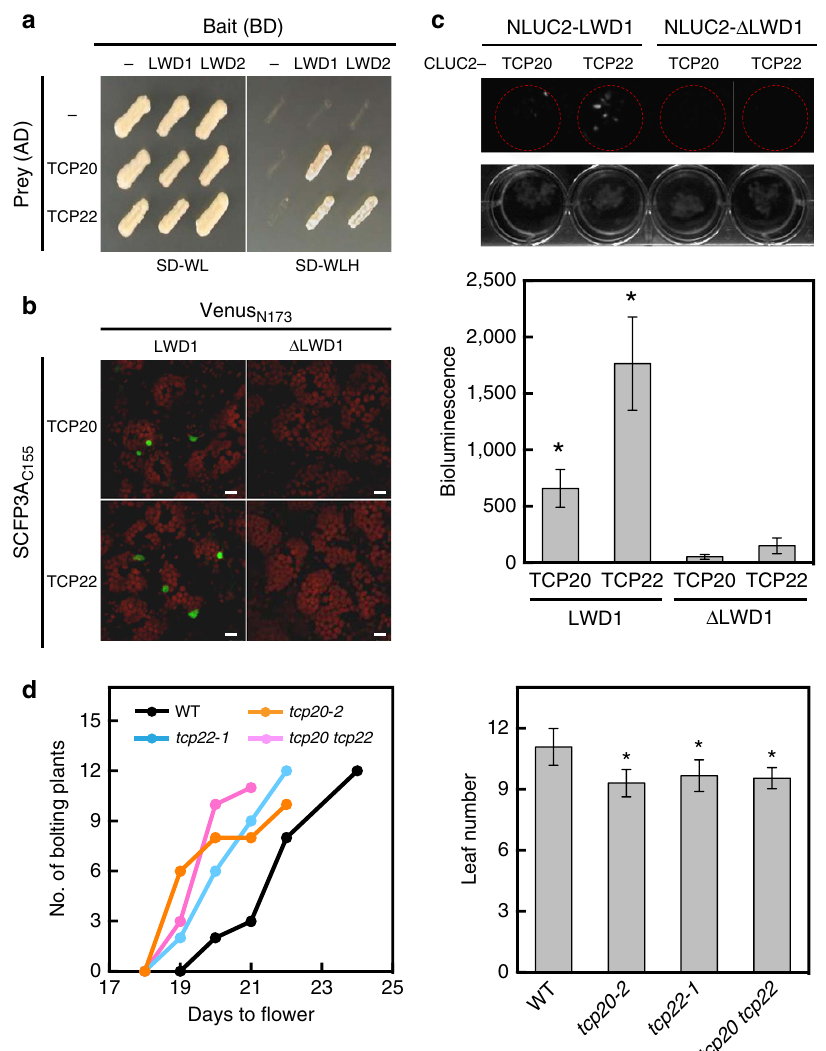
Figure 2 | TCP20/TCP22 interact with clock proteins LWD1/LWD2 and regulate flowering time. ( a ) LWD1/LWD2 and TCP20/TCP22 interact on yeast two-hybrid assay. Positive interactions between LWD1/LWD2 and TCP20/TCP22 were shown by the growth on the selection medium without Trp, Leu and His (SD-WLH þ 2mM 3-AT) for the reporter gene HIS3 . Bimolecular fluorescence complementation (BiFC) assay ( b ) and luciferase complementation imaging assay ( c ) showed that the co-expression between LWD1, but not truncated LWD1 ( D LWD1), and TCP20/TCP22 reconstituted the activity of fluorescence protein (green signal) and luciferase. For luciferase complementation imaging (LCI) assay, one representative image from three independent is shown. Data are mean ± s.e. ( n ¼ 3). Asterisks indicate that LCI activity from the interactions of TCP20/TCP22 with LWD1 is significantly higher than that with D LWD1 (Student’s t test; * P o 0.05). ( d ) Early flowering of tcp20- 2 , tcp22-1 , and tcp20 tcp22 mutant s under long-day conditions. Data are mean ± s.d. ( n Z 10). Asterisks indicate that mutant plants flowered significantly earlier than wild-type plants (Student’s t test; * P o 0.01). Ten to twelve plants for each genotype were planted for scoring for each biological replicate. Similar results were observed in three independent experiments. Scale bars, 10 m